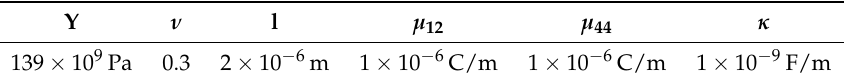
Table 4. Material parameter for the problem depicted in